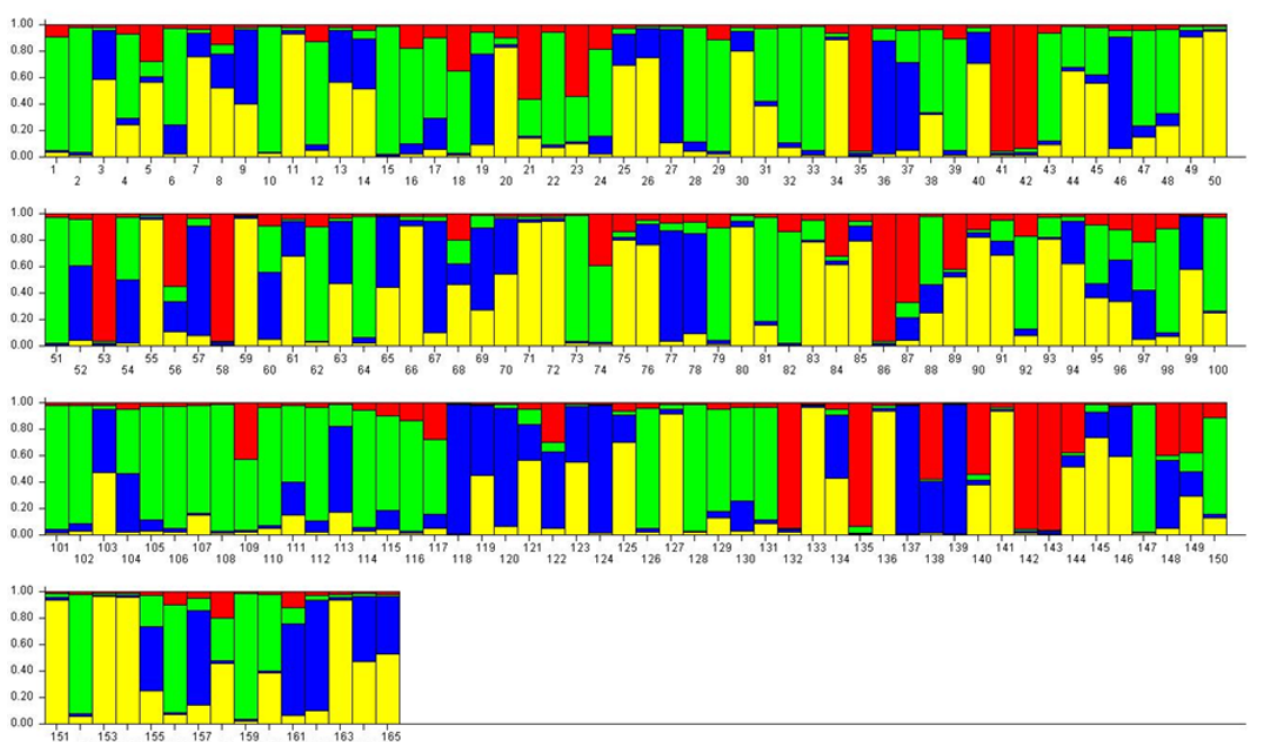
Figure 3. Bar plot of the results from a Bayesian genetic structure analysis with K = 4, green RPP4:1, red RPP4:2, yellow RPP4:3, blue RPP4:4. For accession names, see Supplementary Table